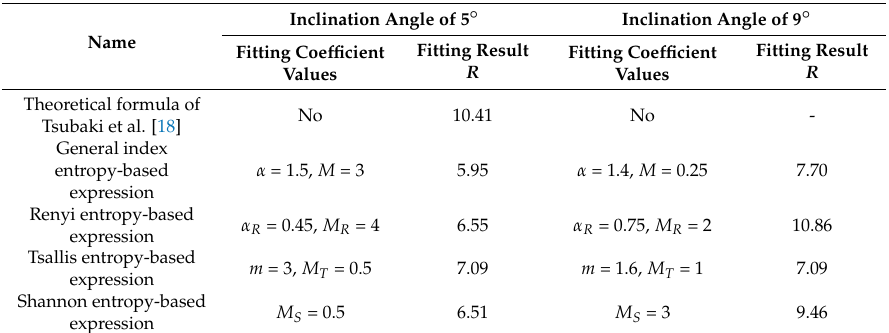
Table 1. Fitting results of the method of Tsubaki et al. [18] and four different entropy-based expressions for observed data from Tsubaki et al. [18] at angles of 5 ◦ and 9 ◦ .